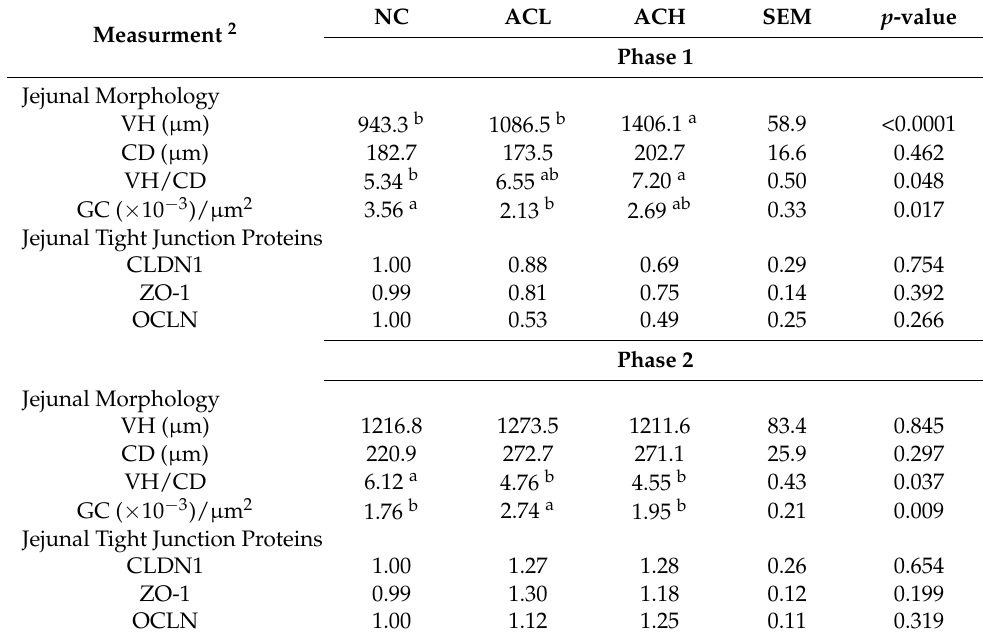
Table 8. Effect of different levels of aging corn on jejunum morphology and mRNA gene expression in broilers fed three different experimental diets 1 .